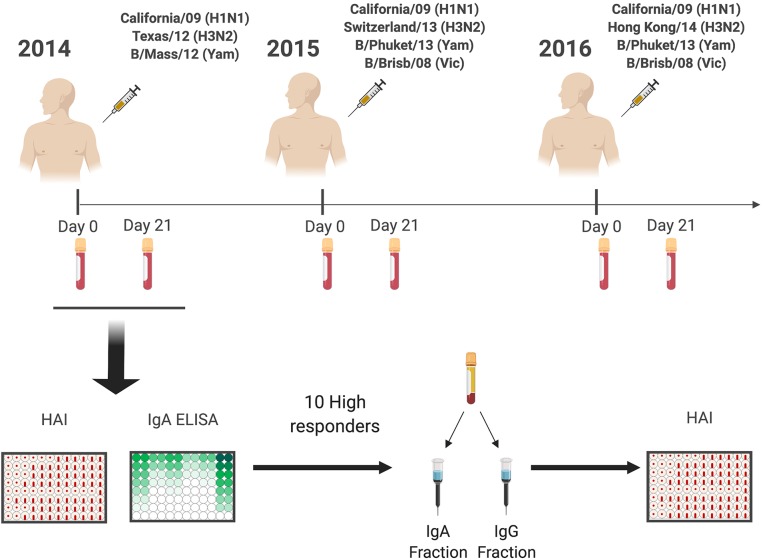
General experimental approach. Healthy subjects (18–35 y.o. and 65–85 y.o.) were vaccinated with standard of care inactivated influenza vaccine for three consecutive years (2014–2016), and serum samples were collected prior (Day 0) and post vaccination (Day 21–28). Serum samples were tested for receptor blocking activity by HAI, or for HA-specific IgA and IgG antibody levels by ELISA. Ten responders with the highest IgA responses were selected for IgA and IgG purification by affinity chromatography and purified fractions used to determine IgA and IgG specific HAI activity.